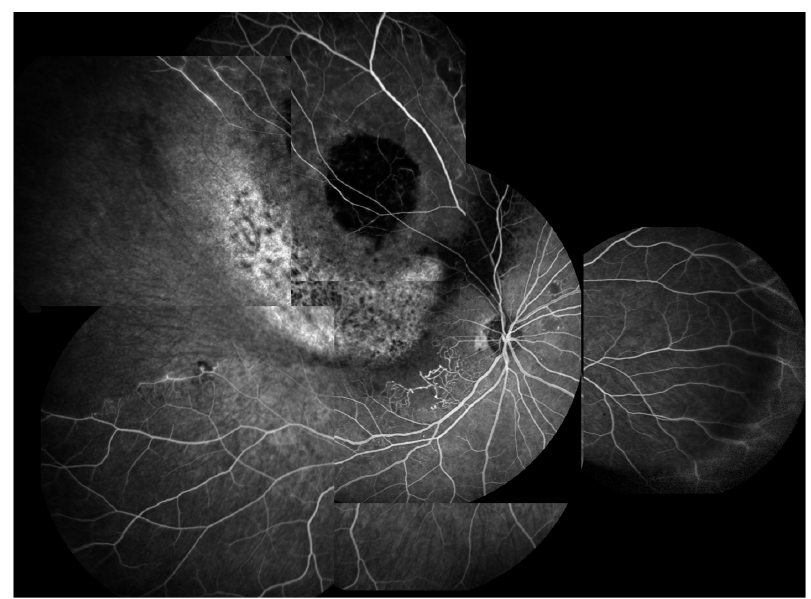
Figure 4. Fluorescein angiography showing chorioretinal atrophy, ischemia (capillary non-perfusion) and abnormal perifoveolar capillary network.